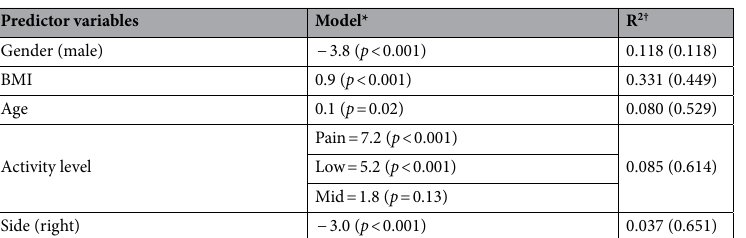
Table 3. Results of a hierarchical linear regression analysis of predictors of fat fraction. The coefficients with their respective p-values are reported for each predictor variable for each model. The coefficients are in FF percentage units. *(FF ~ 1 + gender + BMI + age + activity + side). OHS and pain side were also tested but were not predictors of FF. † The accumulated R 2 after the inclusion of each variable are reported between